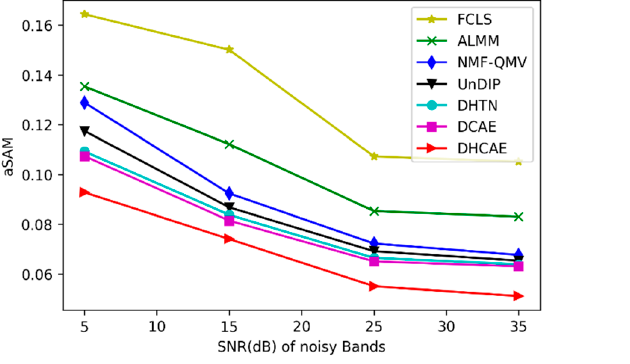
Figure 4 . Synthetic data. Ground truth (GT) map in the first column and extracted abundance maps comparison by different spectral unmixing methods.